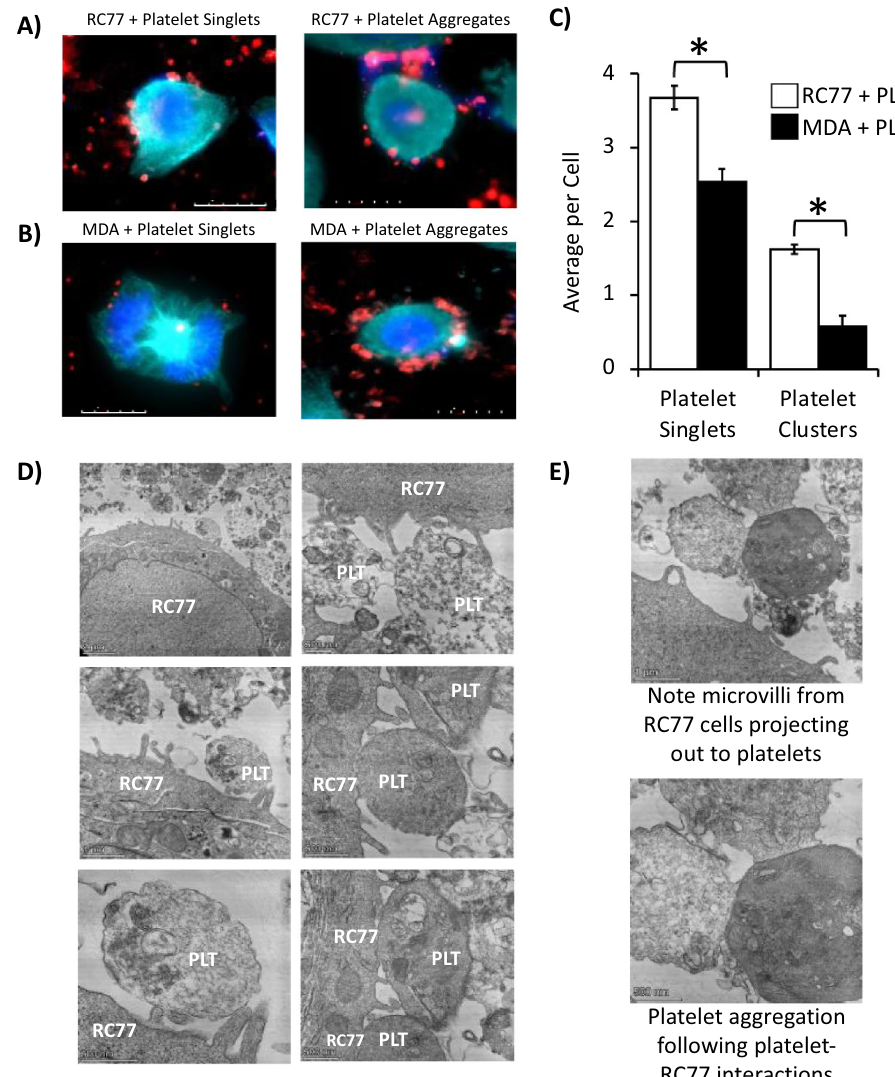
Figure 1. PCa cells physically interact with platelets. Representative fluorescent images of ( A ) RC77 T/E and ( B ) MDA PCa 2b cells incubated with platelets at a cell:platelet ratio = 1:500. Cells were stained with antibody for the P2Y12 receptor (cyan) and DAPI for DNA (blue). Platelets were stained with an antibody for CD41a (red). Inset depicts scale bar in 5 µm intervals. ( C ) Quantification of platelet singlets and clusters/aggregates interacting with RC77 T/E (n = 109 imaged cells incubated with platelets at a cell:platelet ratio = 1:500) and MDA PCa 2b (n = 127 imaged cells incubated with platelets at a cell:platelet ratio = 1:500). Bar graphs represent the mean ± SEM; Student’s t -test, * P < 0.05. ( D ) Representative transmission electron micrograph (TEM) images depicting physical interactions between RC77 T/E cells and platelets. ( E ) Magnified image of microvilli-like structures projecting from RC77 T/E cell toward platelet aggregates (top panel) and representative image of platelet-platelet focal adhesions indicative of PCa cell-stimulated platelet aggregation (bottom